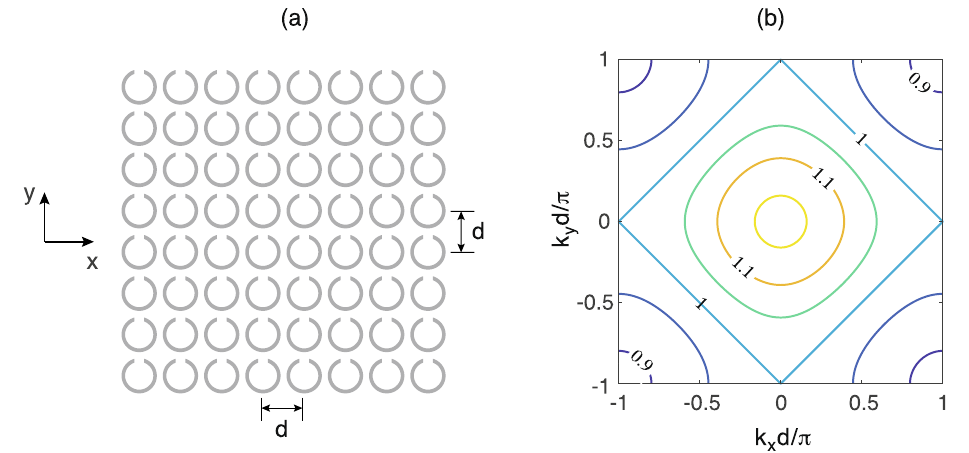
Figure 12. A schematic of a planar isotropic metasurface ( a ) and its lossless MI dispersion (iso-frequencies of ω/ω 0 vs k x and k y ) for κ x